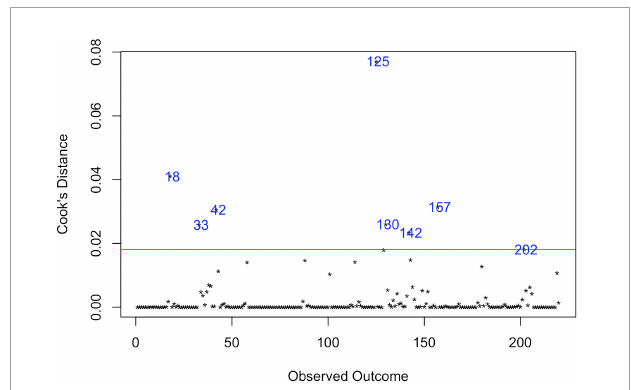
FIGURE5 Influential observations by Cooks distance. 18—Hewitt et al. (43); 33—Zahorodny et al. (37); 42—Akhter et al. (44); 125—Kim et al. (47); 130—Aguilera et al. (38); 142—Baio et al. (45); 157—Maenner et al. (46); 202—Shaw et al.